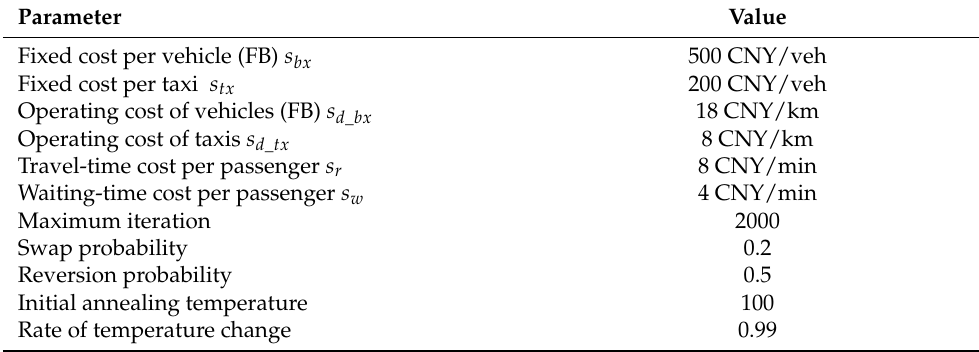
Table 7. Default parameter